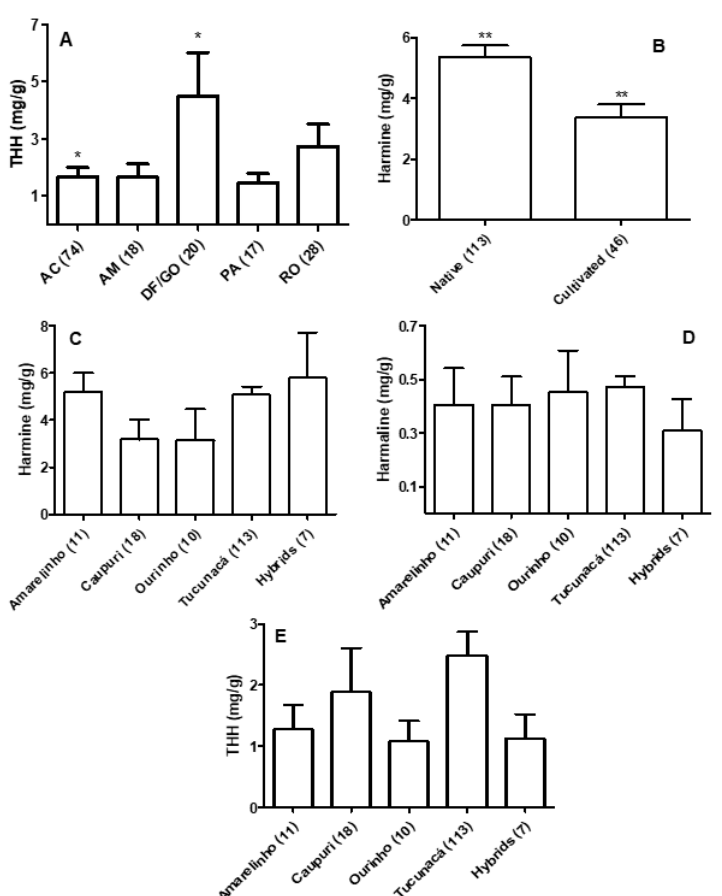
Figure 4. ( A ): THH levels in Banisteriopsis caapi samples collected in different regions; two samples collected in the State of Minas Gerais were not included. ( B ): Harmine levels in native and cultivated B. caapi samples. ( C – E ): β -carboline levels in different B. caapi samples. Hybrids include plants described as tucunacá with nodes (2 samples), caupuri without nodes (2 samples), pajezinho (1 sample), caboquinho (1 sample), and quebrador (1 sample). Levels are mean ± standard error of the mean (SEM). * p < 0.05; ** p <